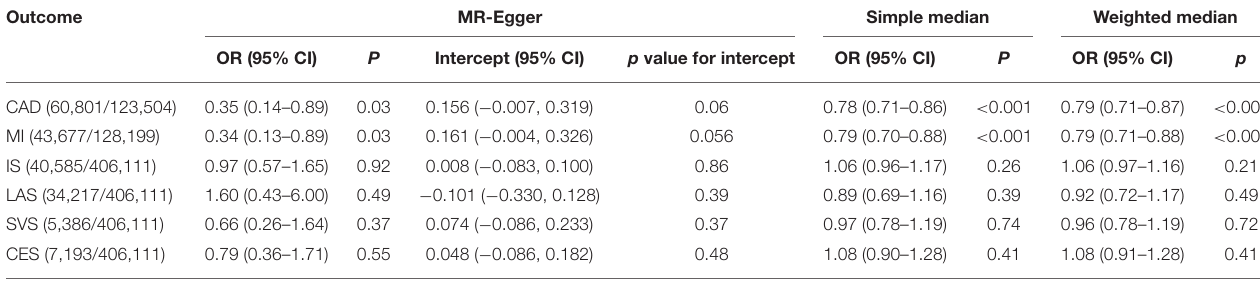
TABLE 5 | MR statistical sensitivity analyses using 5 SNPs as the instrumental variables * . Outcome MR-Egger Simple